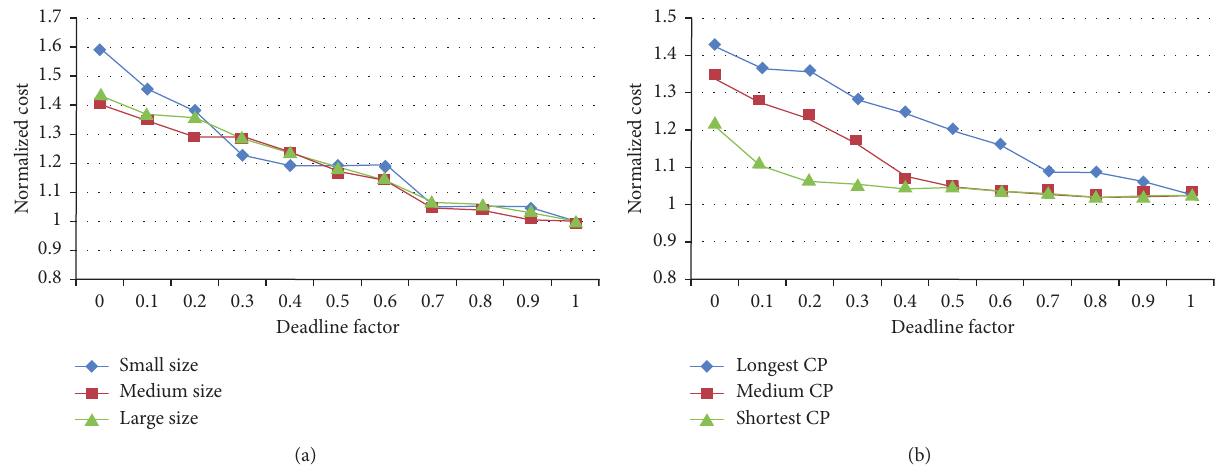
Figure 5: The normalized cost of resource provisioning with GRP4RW. (a) Three workflows with different sizes. (b) Same workflow size but different CP length.